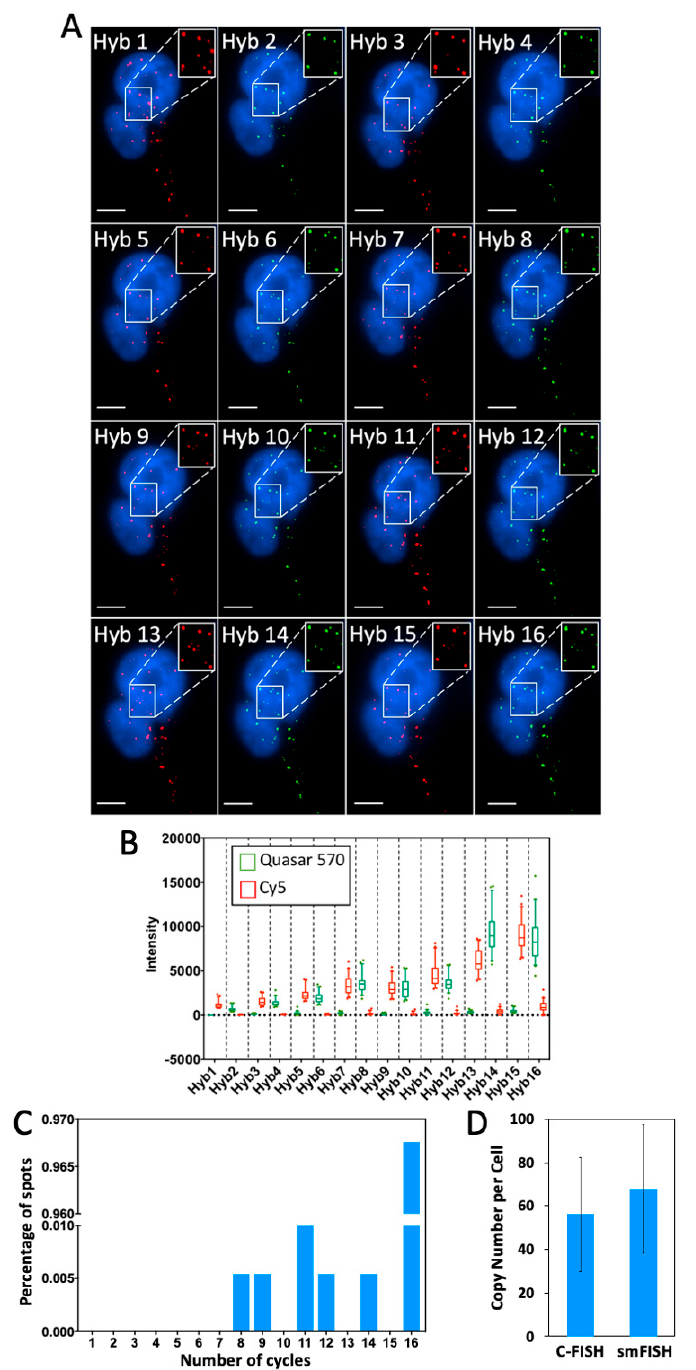
Figure 4. ( A ) Ki67 transcripts in HeLa cells are detected in 16 cycles of C-FISH. Cy5 and Quasar 570 labeled decoding probes were used in the odd and even hybridization cycles, respectively. ( B ) Intensity distribution of the Ki67 transcripts ( n = 45 spots) in 16 cycles of C-FISH. In each cycle, the signal intensities in Quasar 570 and Cy5 channels are shown in green and red, respectively. ( C ) A fraction of Ki67 spots ( n = 1000 spots) appear in different number of C-FISH cycles. ( D ) Comparison of the Ki67 mean copy number per cell ( n = 30 cells) of transcripts measured by C-FISH and conventional single molecule FISH (smFISH) ( p > 0.52). Scale bars, 5 µm.